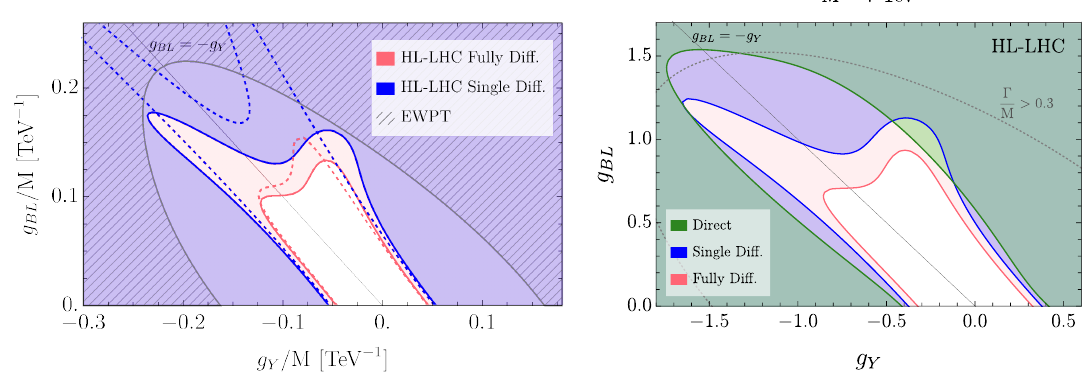
Figure 6 . Left panel: 95% CL exclusion reach in the ( g Y /M, g BL /M ) plane from EWPT (gray shaded region) [39] and projected exclusion at the HL-LHC (blue and orange shaded regions). Right panel: comparison of direct (green shaded region) and indirect (blue and orange shaded regions) exclusions at the HL-LHC for a heavy vector of mass M = 7 TeV. In both panels the blue shaded region corresponds to the fully-differential fit, while the orange shaded region is obtained with the single-differential one. In the left panel, the dashed lines correspond to the exclusion reach obtained including only the linear terms in the fit, while the solid ones correspond to the full fit taking into account also the quadratic